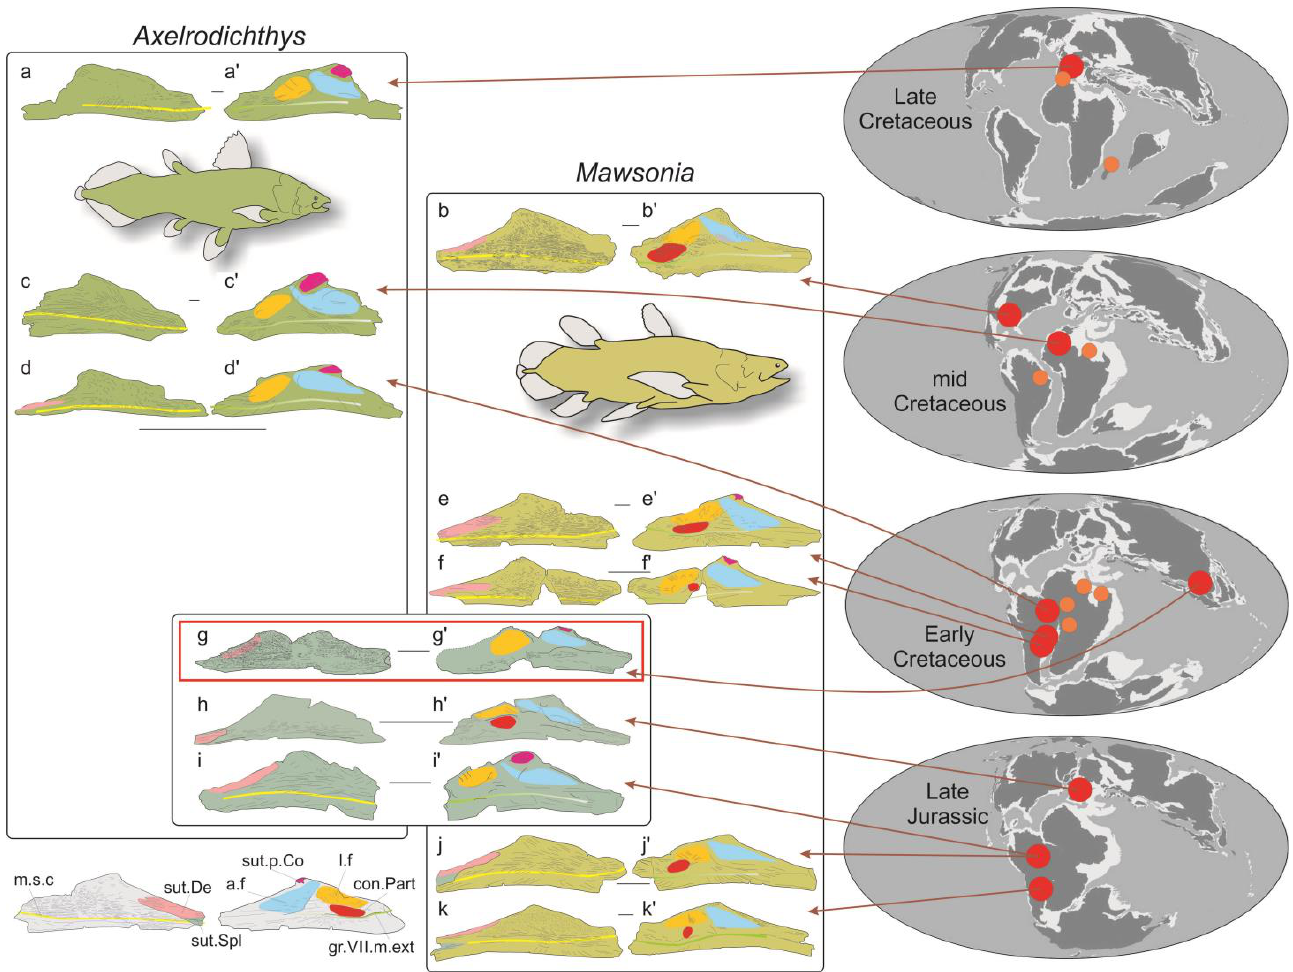
Figure 3. Comparison in labial ( a – k ) and lingual ( a’ – k’ ) views between left angular PRC 160, Kham Phok locality (( g ), framed in red), and other angulars referred to the Mawsonia / Axelrodichthys complex, discovered in various parts of the world dated between the Late Jurassic and the Late Cretaceous (red spots). Remark: Specimens i and j, figured by Cupello et al. [4] and Batista et al. [5] are both from a formation called Missão Velha and Brejo Santo, respectively, with an uncertain age of the Late Jurassic or Late Cretaceous. ( a ) A. megadromos , Southern France, terminal Cretaceous (inverted); ( b ) M . sp., USA, Woodbine Fm. (inverted); ( c ), A. lavocati , Northern Africa, ‘Continental Intercalaire’; ( d ) A. araripensis , Brazil, Santana Fm. (inverted); ( e ) M. gigas , Brazil, Marfim Fm.; ( f ) M. gigas , Brazil, Sanfranciscana Fm. (inverted); ( h ) mawsoniid indet., UK, Kimmeridge Clay; ( i ) mawsoniid indet., Brazil, MissãoVelha/Brejo Santo Fm.; ( j ) M. gigas , Brazil, MissãoVelha/Brejo Santo Fm. (inverted); ( k ) M. gigas , Brazil, Taruarembó Fm. Data from Cavin et al. (2021) [22]. Orange spots indicate other mawsoniid remains, not detailed here. The main anatomical structures are figured with colored areas. Abbreviations: a.f, adductor fossa (blue); con.Part, contact surface with prearticular (red); gr.VII.m.ext groove for external mandibular ramus of VII (green); l.f, longitudinal fossa (orange); m.s.c, mandibular sensory canal (yellow); sut.p.Co, sutural contact surface with principal coronoid (purple); sut.De: sutural surface for dentary (pink); sut.Spl: sutural surface for splenial